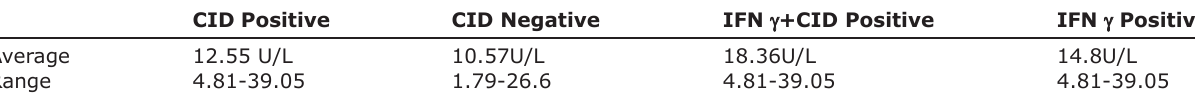
Table-1: Average values of adenosine deaminase in cattle and buffaloes. CID Positive CID Negative